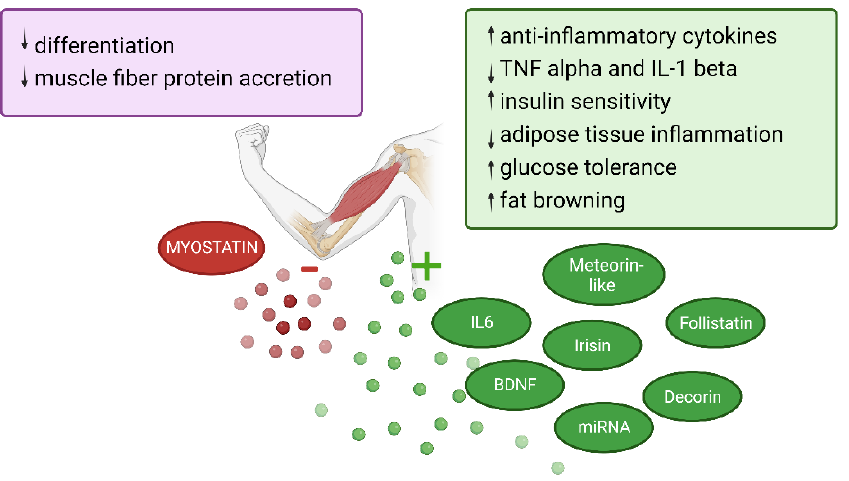
Figure 4. Schematic of the effects of exercise on the muscle secretome and the systemic consequences. Exercise induces an increase in meteorin-like, follistatin, decorin, irisin, BDNF, but also in cytokines, such as IL-6 and miRNAs. This leads to an increase in anti-inflammatory cytokines, in insulin sensitivity, in glucose tolerance and in fat browning, but a downregulation of the TNFα and IL- 1β. Myostatin synthesis and secretion is decreased during exercise , causing a decrease in muscle differentiation and muscle fiber protein accretion. The + symbol and the green color emphasize the myokines and miRNA with an increased expression and/or secretion during exercise. The – symbol and the red color highlight the one with a decreased expression and/or secretion during exercise. The dots represent the myokines gradients. Created with BioRender.com.